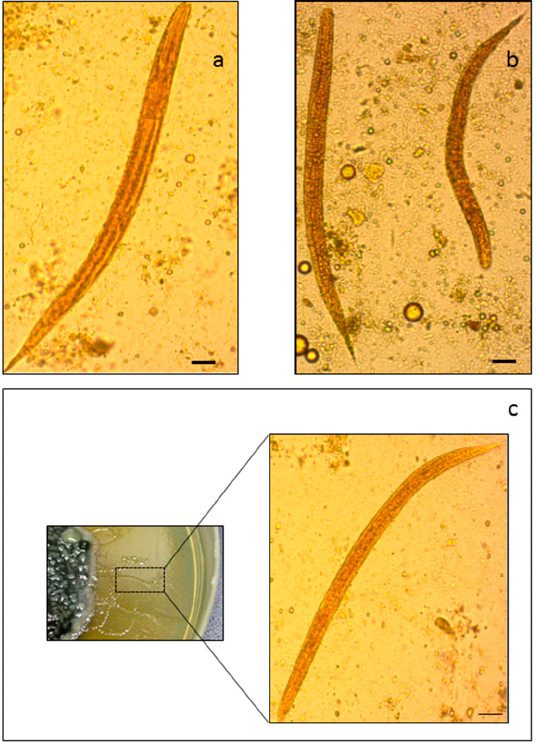
Figure 1. Light microscope-based characterization of Strongyloides stercoralis . Rhabditiform larvae of S. stercoralis are reported in panels ( A – C ) at 40× magnification. The inset refers to a larva onto an of S. stercoralis are reported in panels ( a – c ) at 40 × magnification. The inset refers to a larva onto an agar plate. agar